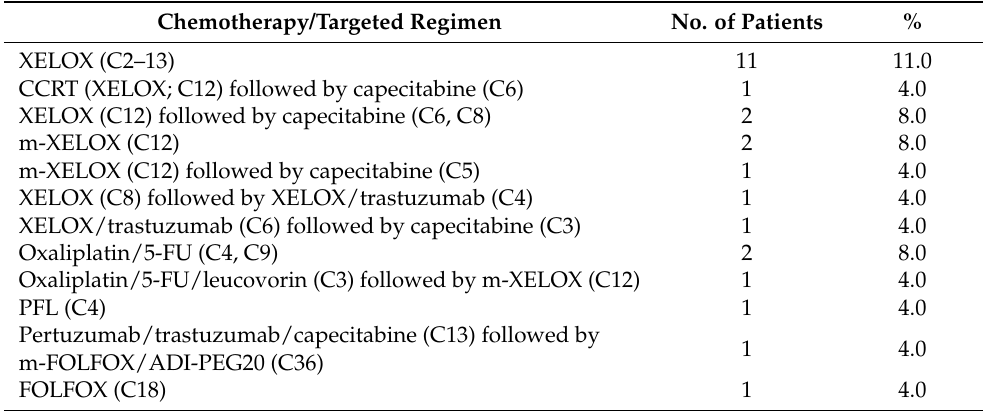
Table 3. Chemotherapy/targeted therapy regimens in patients that underwent conversion